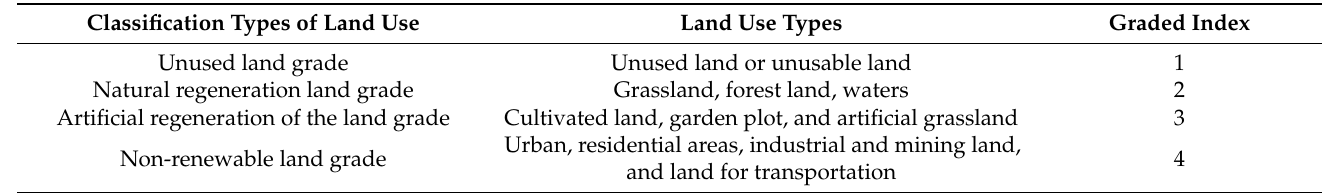
Table 4. Grades of land use degree